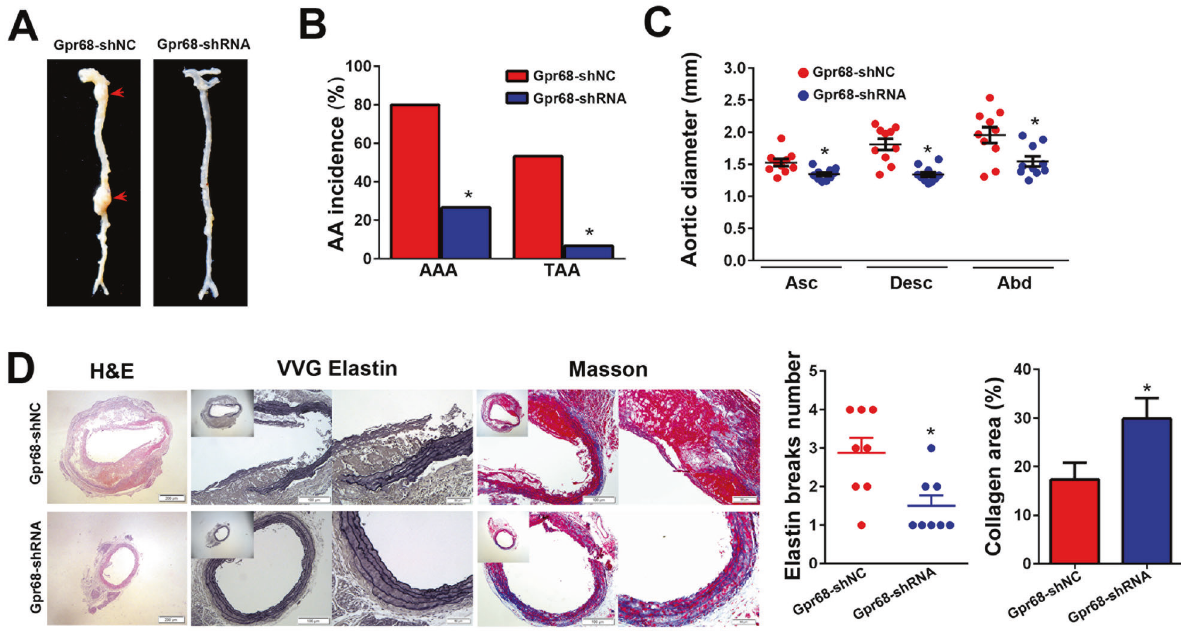
Fig. 7 Gpr68 inhibition prevents aneurysm formation induced by AngII administration in Tsc2 MKO ApoE – / – mice. Tsc2 MKO ApoE – / – mice were treated with shRNA-Gpr68 or negative control before AngII pump implantation. At 28 days after the osmotic pumps implantation, mice were sacri fi ced, and their aortas were obtained. A Representative images of aortic specimens from shRNA-Gpr68 or negative control treated mice. B Incidence of AAA and TAA in shRNA-Gpr68 or negative control treated mice ( n = 15). C Comparison of maximal diameters in the ascending thoracic (Asc), descending thoracic (Desc), and suprarenal abdominal (Abd) aortic segments measured with vernier caliper ( n = 10). D Representative hematoxylin and eosin (H&E), Verhoeff-van Gieson (VVG), and Masson staining of the abdominal aortic sections. Quantifcation of elastin breaks per section in aortic cross sections ( n = 8). Quantitative analysis of Masson staining signals ( n = 5). * P < 0.05, vs. mice treated with negative control.